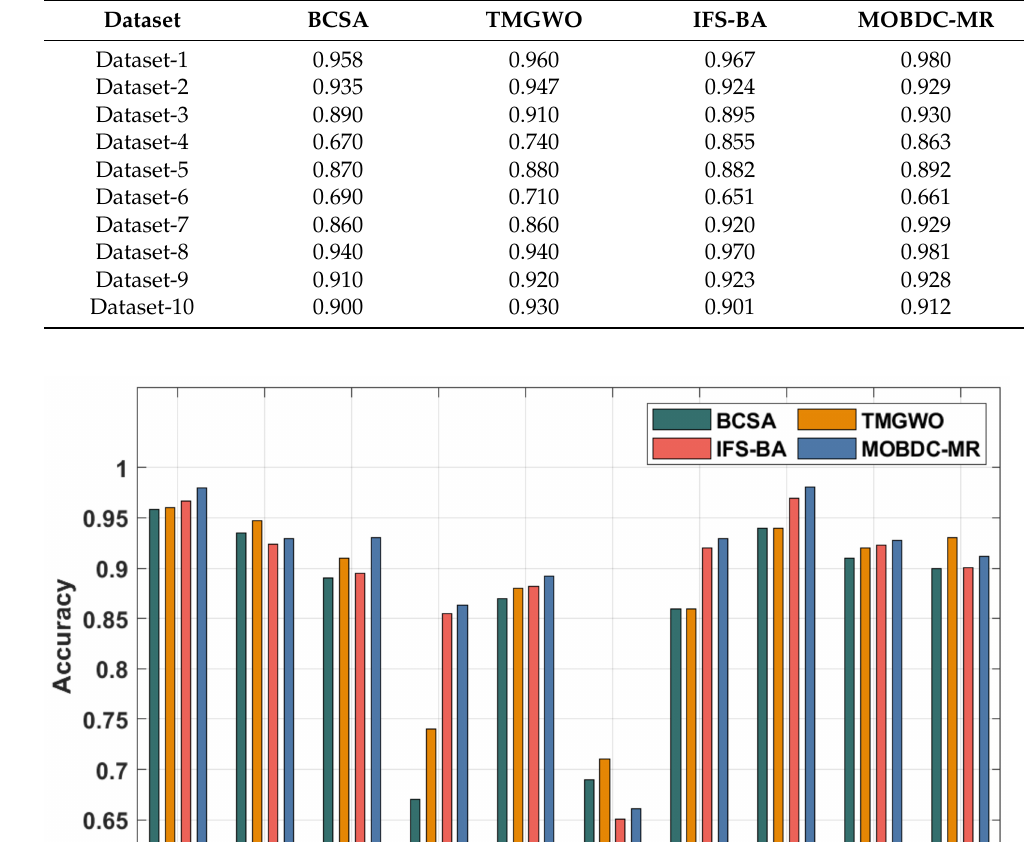
Table 6. Overall accuracy analysis of MOBDC-MR with existing techniques.